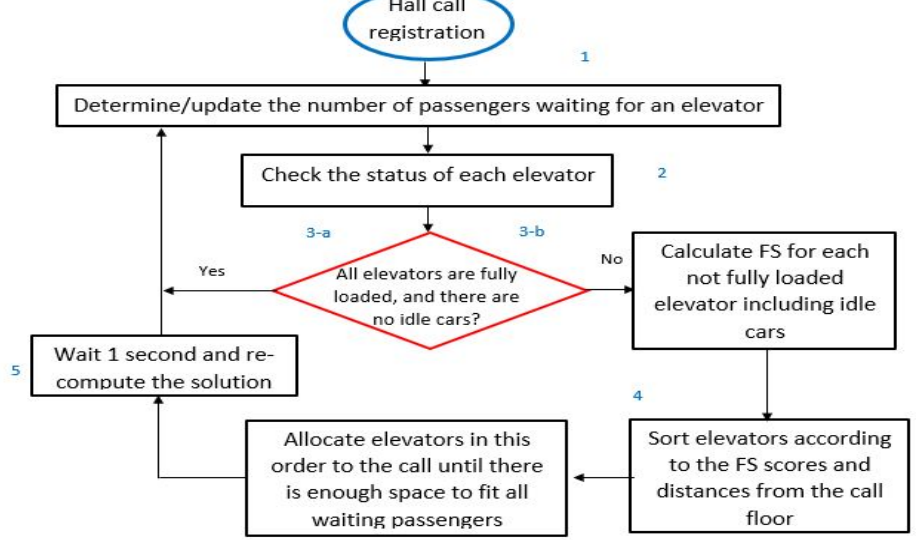
Figure 2. Flowchart of modified NC algorithm.